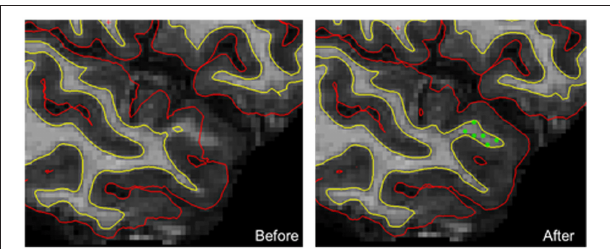
FIGURE 1 | An example of manual corrections applied in case of wrong estimation of pial and/or white cortical surfaces. In this individual, the FreeSurfer software did not correctly estimate both white and pial surfaces in the upper part of the temporal pole. Manually adding checkpoints to the white matter surface results in better surface estimation after a second extraction process (yellow line, white surface; red line, pial surface; green dots,